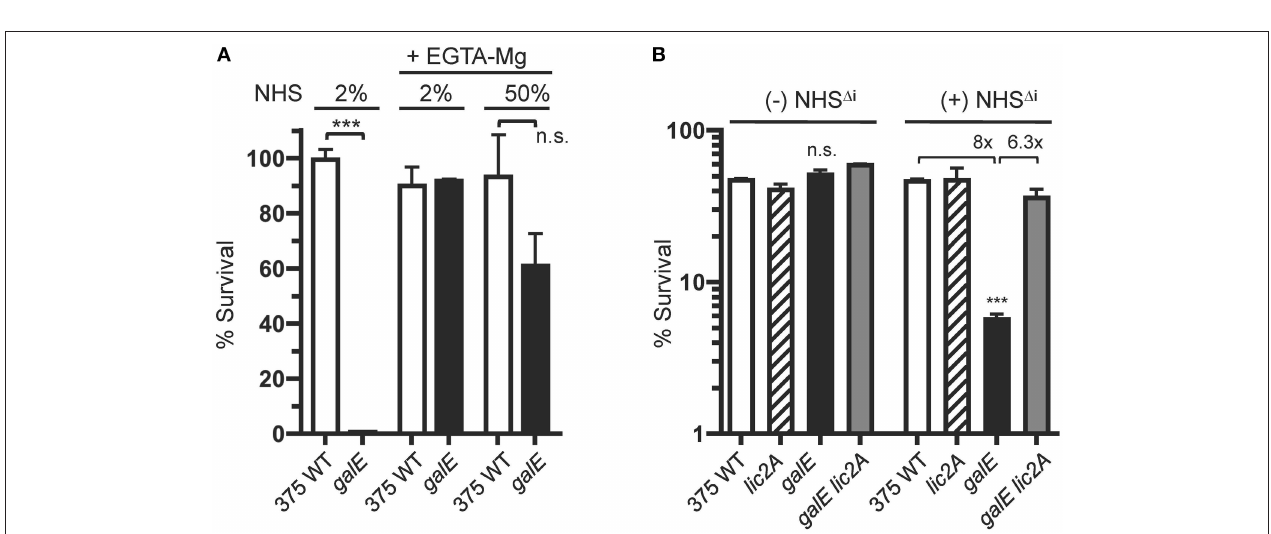
FIGURE 10 | Killing of the NTHi 375 galE mutant by complement requires serum antibody. (A) Survival of NTHi 375 wild-type (WT) and isogenic galE mutant grown on MIc SA medium assayed following incubation with the indicated percentage of NHS in the absence or presence of EGTA and MgCl 2 at 37 ◦ C for 30min. Percent survival is the ratio of CFU recovered from serum treated samples ( ± EGTA and MgCl 2 ) at 30min to CFU recovered from NHS 1 i treated samples ( ± EGTA and MgCl 2 ). (B) Antibody-dependent killing of the galE mutant by NHS. Viability of NTHi 375 wild-type (WT) and isogenic deletion mutants grown on MIc SA following incubation with or without 10% unabsorbed NHS 1 i followed by incubation with 3% IgG/IgM antibody depleted human complement active serum (HC) at 37 ◦ C for 30min. Percent survival is the ratio of the number of CFU recovered at 30min. relative to the input CFU at T = 0min. of incubation. Log transformed survival ratios were evaluated by one-way ANOVA with Bonferroni’s multiple comparison test (*** p < 0.001; n.s., not statistically significant). In (B) , the galE mutant differed significantly from the other three strains within the NHS 1 i treatment group. The mean of duplicate samples is shown. Lower limit of detection is ∼ 0.25%